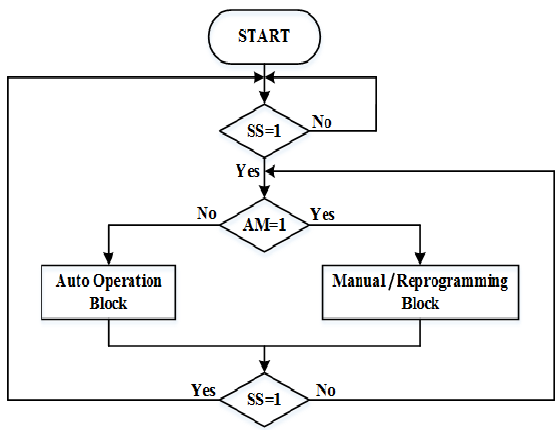
Fig. 5. PLC Logic Program General